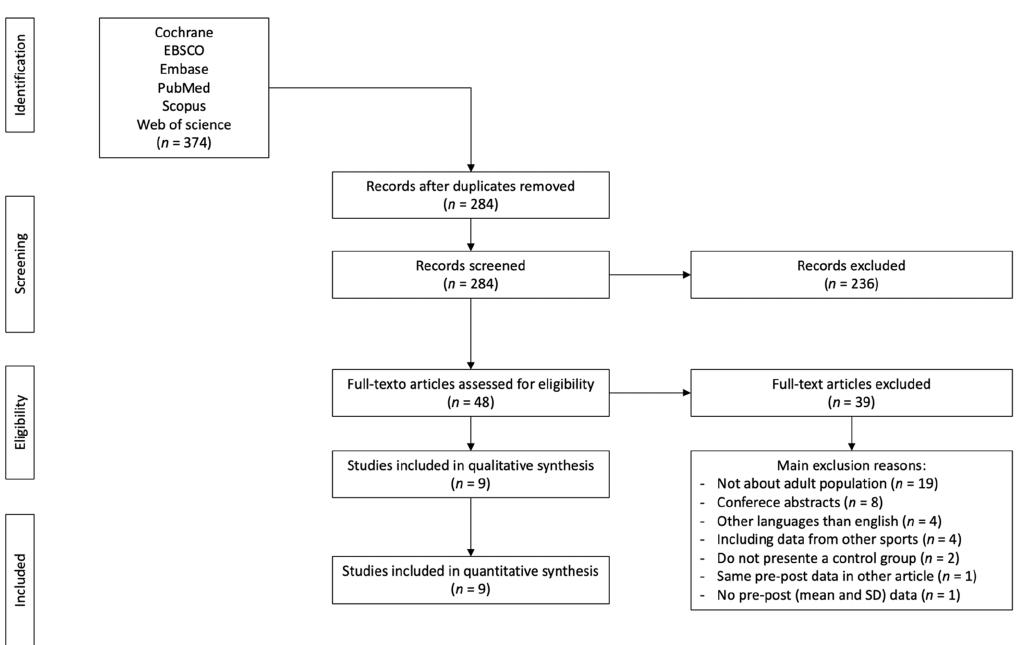
Figure 1. Preferred reporting items for systematic reviews and meta-analyses (PRISMA) flow diagram highlighting the selection process for the studies included in the current systematic review. Table 2. Characteristics of the included studies and outcomes extracted.